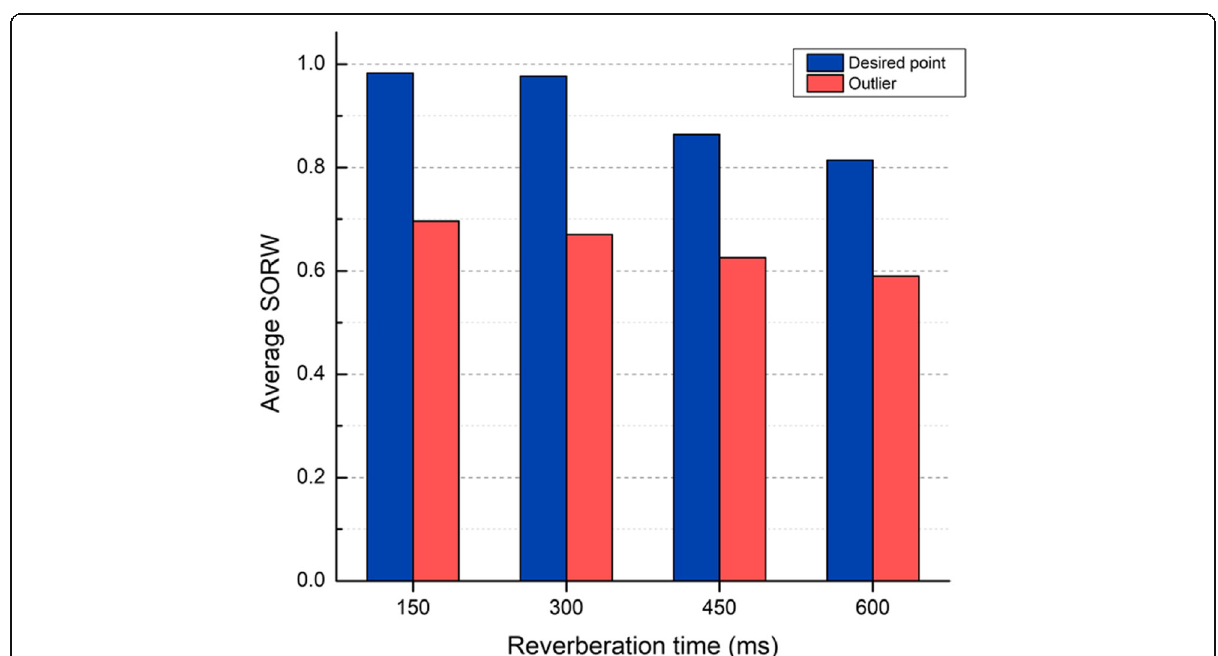
Fig. 5 SORW of desired points and outliers with different reverberation